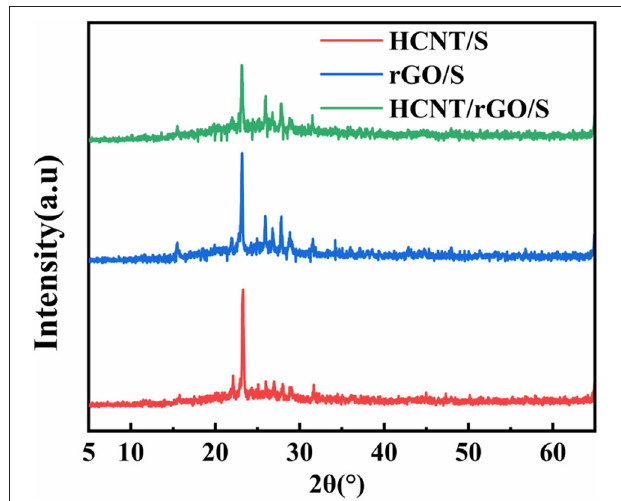
FIGURE 2 | XRD patterns of HCNT/S, reduced graphene oxider GO/S, HCNT/reduced graphene oxider